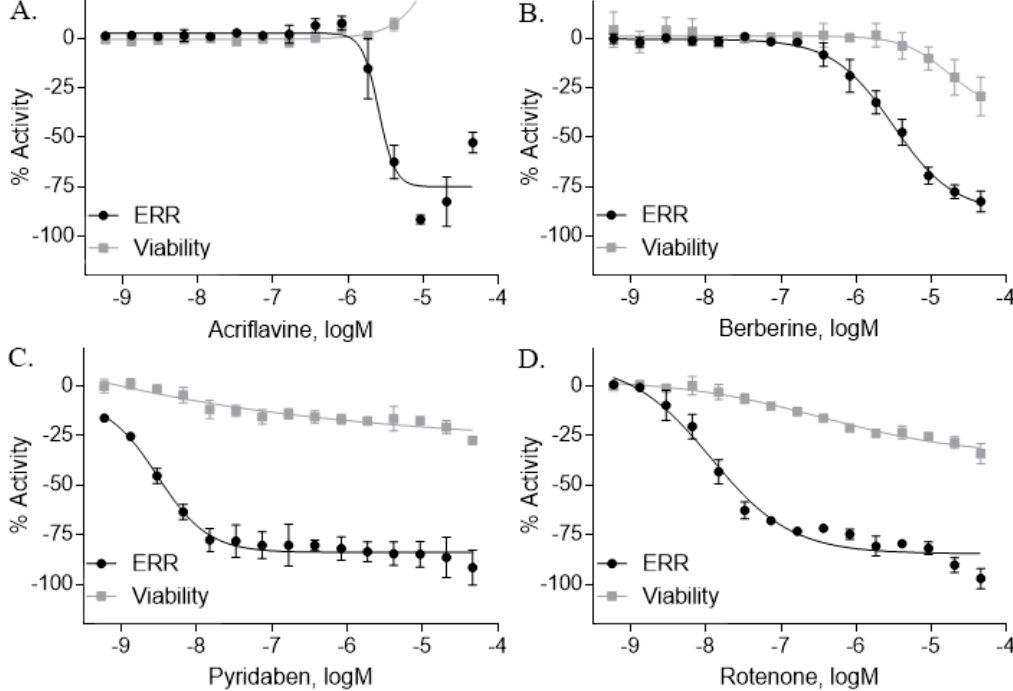
Figure 2. Concentration response curves of potential novel ERR α pesticide antagonists. Fifteen point titrations, from the 10K ERR α antagonist and viability screen, of acriflavine ( A ), berberine ( B ), pyridaben ( C ), and rotenone ( D ) were performed. The ERR reporter HEK293 cell line was treated with each compound for 18 h. The luminescence intensity was calculated after the addition of ONE-Glo to each well. The efficacy of each compound was then compared to the positive control, XCT790. Data were expressed as mean ± SD from triplicate experiments for each assay.